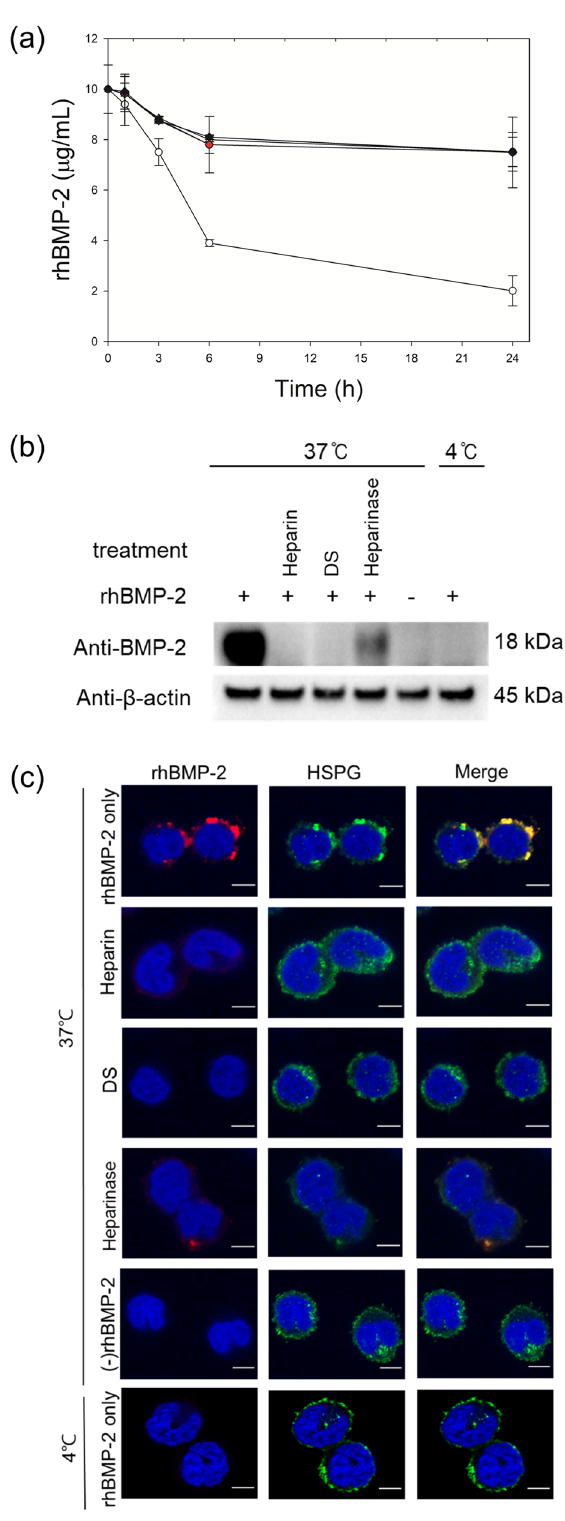
Figure 1. Active internalization of rhBMP-2 into DG44 cells. ( a ) Profiles of rhBMP-2 during incubation with and without cells. With cells at 37 °C in the absence of heparin and DS (white circle), with cells at 37 °C in the presence of 0.1 g/L heparin (blue diamond) or 0.5 g/L DS (red diamond), with cells at 4 °C in the absence of heparin and DS (green circle), without cells in the absence of heparin and DS at 37 °C (white triangle) or 4 °C (black triangle). The error bars represent standard deviations calculated from six independent experiments. ( b ) Western blot analysis of intracellular rhBMP-2 at 37 °C or 4 °C. ‘+’ and ‘−’ indicate presence and absence, respectively. ‘Heparinase’ indicates cells pretreated with heparinase I/III. β actin was used as the loading control. ( c ) Confocal microscopy to examine the intracellular location of rhBMP-2. Intracellular rhBMP-2 was stained red, while HSPGs were stained green. The nuclei were stained blue using DAPI. The merge images indicate co-localization (yellow) of rhBMP-2 and HSPGs. Scale bar 5